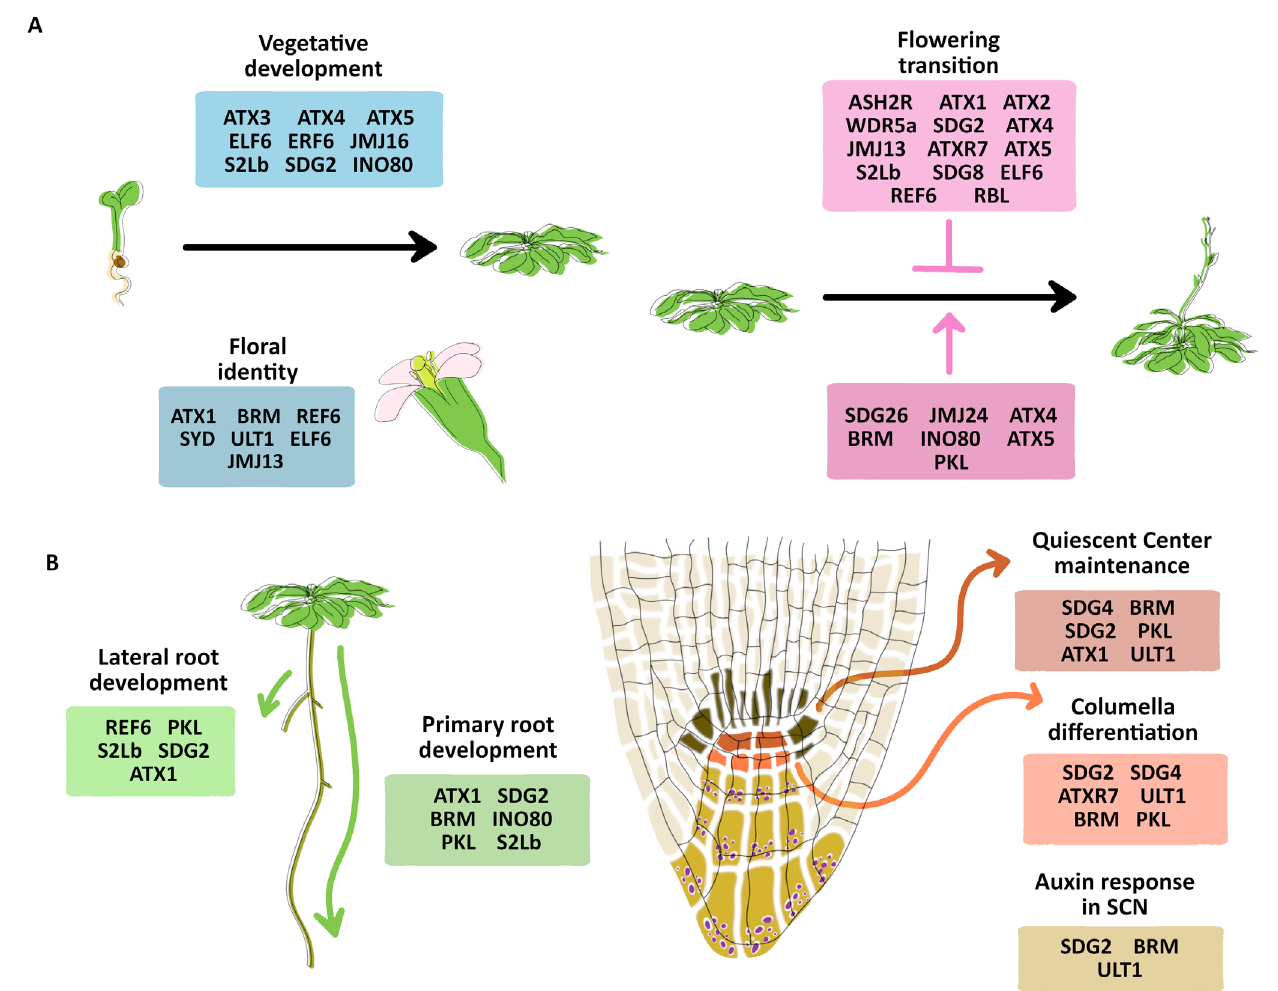
Figure 3. Roles of TrxG proteins in development. ( A ) List of TrxG proteins involved in the vegetative development, floral identity, and flowering transition. The pink arrow indicates flowering promotion, whereas the flat pink arrow indicates a flowering restriction. ( B ) List of TrxG proteins involved in the lateral and primary root development, including the quiescent center maintenance, columella differentiation, and auxin response on the SCN. SCN: Stem cell niche.